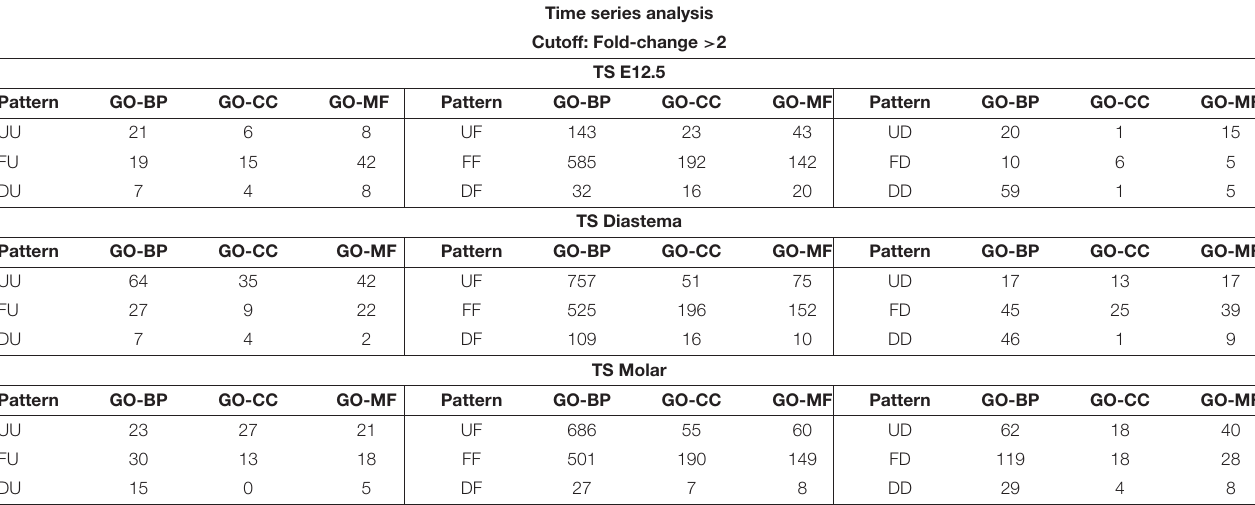
TABLE 1 | Gene Ontology (GO) classification of time series